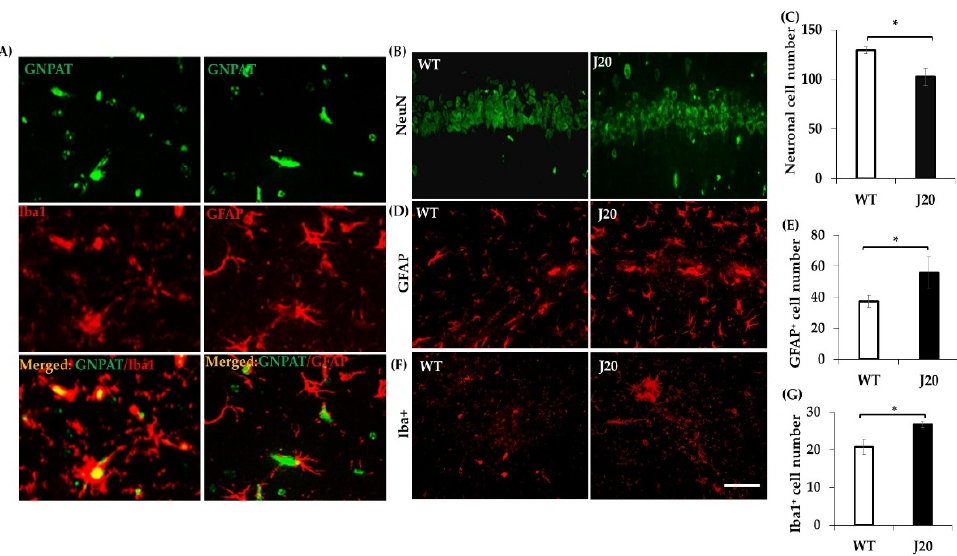
Figure 4. Localization of GNPAT with glial cells in J20 mice, and change of neuronal and glial cell at 9 months in J20 and WT mice. Double immunofluorescence staining of GNPAT with Iba1 and GFAP was performed, as described in the Materials and Methods. Representative immunophotomi- crographs are shown ( A ). The change of neuronal and glial cells in the hippocampus of J20 and WT mice were evaluated by NeuN, Iba1, and GFAP immunofluorescence staining. The number of cells were counted in stained tissue sections at 40 × magnification. The representative immunophotomi- crographs and analysis results of NeuN ( B , C ), GFAP ( D , E ), and Iba1 ( F , G ) are shown. The numerical data is expressed as the average ± SD of 3 mice in a group. Statistical significance is denoted as follows: * p < 0.05. Scale bar = 20 µ m ( A ) and 100 µ m ( B – F